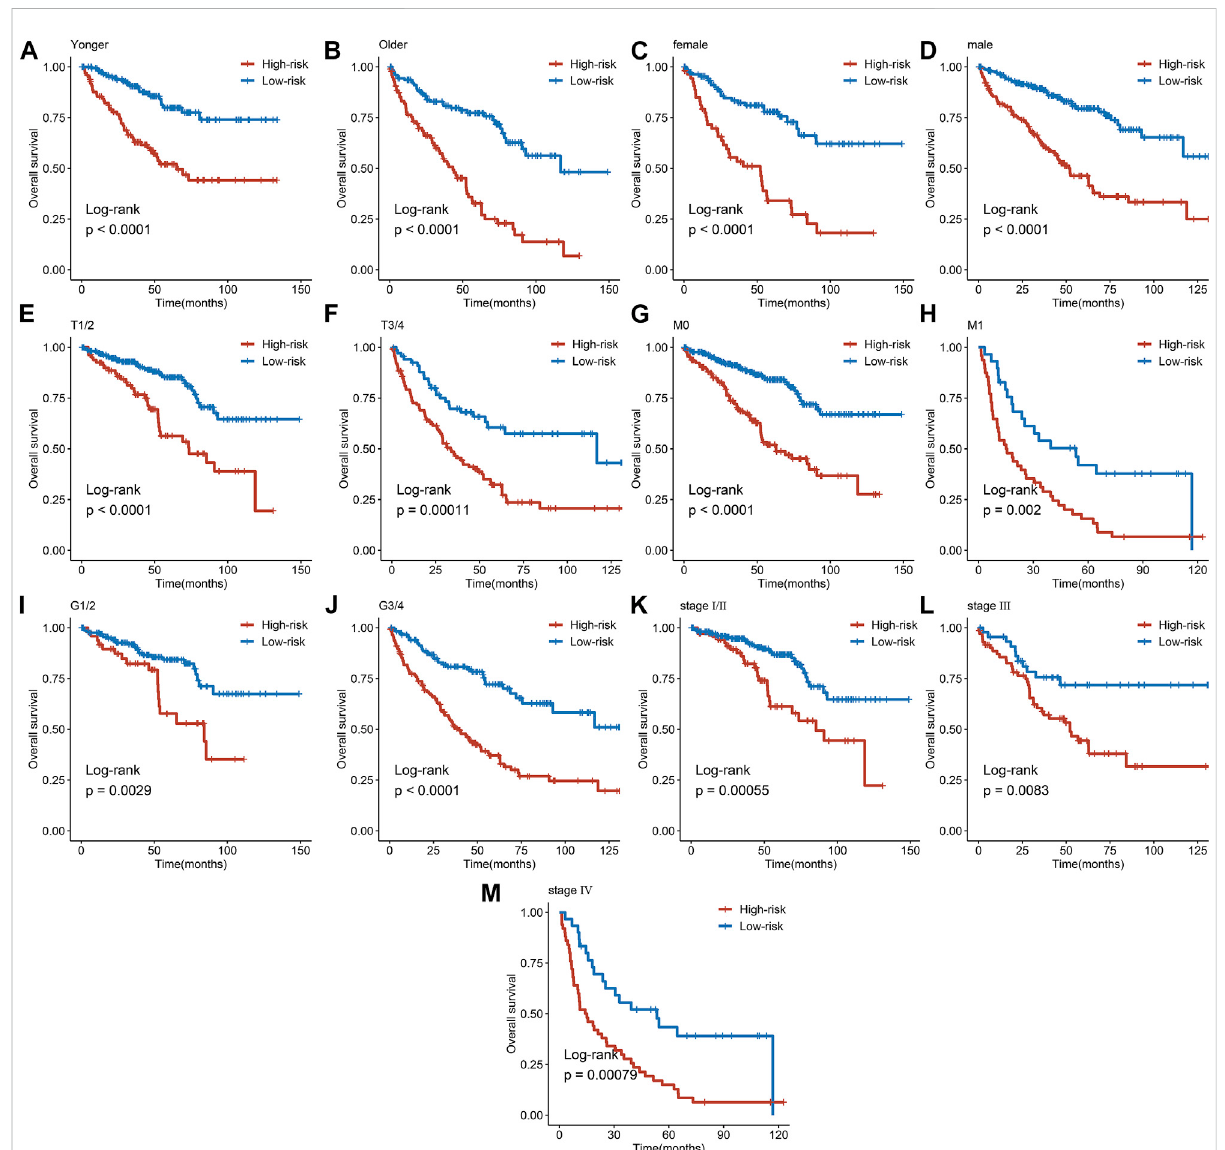
FIGURE 7 SubgroupanalysisoftheAAM-relatedprognosticgenesignatureaccordingtoage (A,B) ,gender (C,D) ,Tstage (E,F) ,Mstage (G,H) ,grade (I,J) , and tumor stage (K, M) ; T, AJCC TNM tumor stage; M, AJCC TNM metastasis stage; G, WHO grade classi fi cation; tumor stage, AJCC tumor clinical